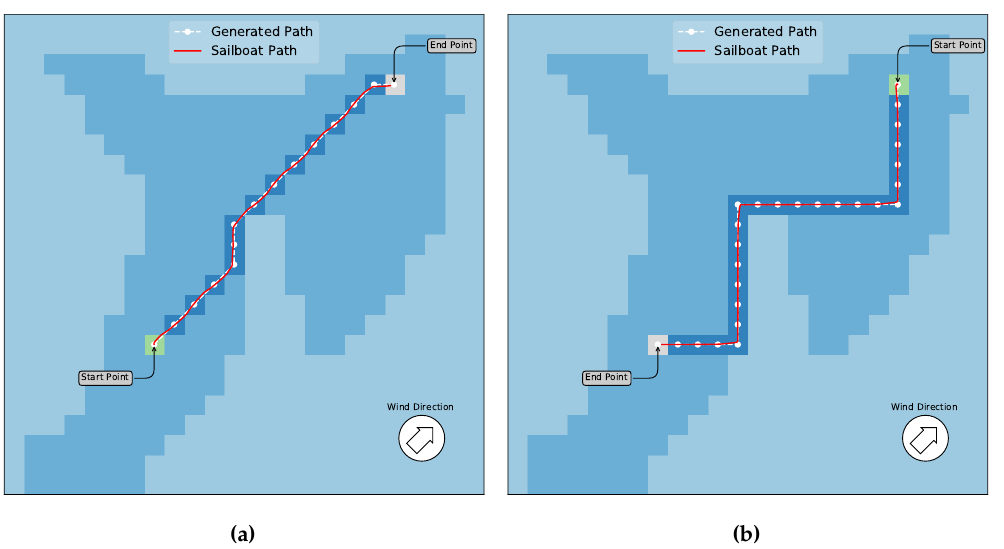
Figure 12. A similar scenario as in Figure 11b with obstacles added to the map. In ( a ), the boat and wind directions are the same. Thus, the path can be generated using all directions. The final path is changed if compared with the first case, in order to avoid the obstacles. The red line is the final sailboat trajectory performed on the simulator. In ( b ), once the boat direction is contrary to wind, a zigzag path is generated, with the action down-left not allowed in this case. Due to obstacles between the start and end points, the algorithm created a different